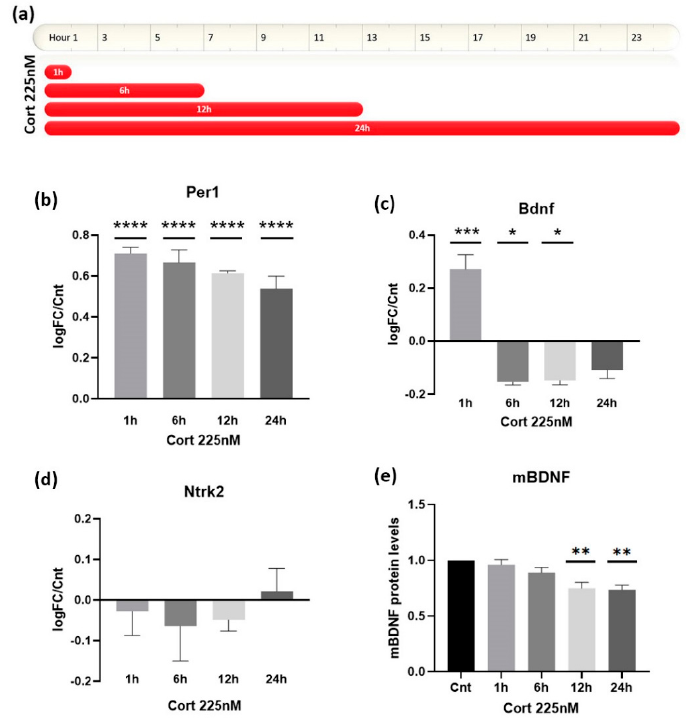
Figure 1. ( a ) Schematic illustration of the experimental design that was used to study the short-term and long-term transcriptional effects of Cort on Bdnf in astrocytes. ( b ) Cort administration (225 nM) strongly upregulates Per1 mRNA expression levels on astrocytes, with effects lasting up to 24 h. qRT-PCR was performed in RNA samples collected after each timepoint, and the results are ex- pressed as the logarithmic fold change (logFC) normalized to the untreated control. ( c ) Cort on as- trocytes mediates a two-stage response in the expression of Bdnf . Rapidly (1 h) after Cort admin- istration, the mRNA levels of Bdnf start to elevate significantly, while later, a persistent inhibitory effect follows that can last for up to 24 h. ( d ) Cort administration (225 nM) had no effect on the expression of the mRNA levels of the TrkB gene, Ntrk2 , on astrocytes. ( e ) ELISA measurements of mBDNF protein levels on astrocytes reveal no change 1 h after Cort stimulation but a statistically significant decrease after 12 h and 24 h. The results from the ELISA measurements are represented as normalized to the untreated control condition. n = 3 for each experiment. * p < 0.05, ** p < 0.01, *** p < 0.001, **** p < 0.0001; one-way ANOVA. Data are mean ± S.E.M.